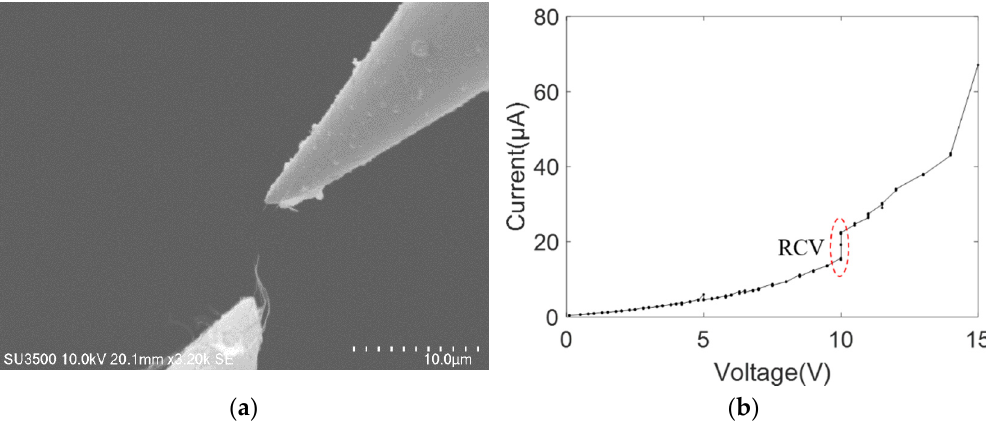
Figure 10. MWCNT bundle contacting with two platinum-coated tungsten probes ( a ) SEM image; ( b ) current–voltage curve.